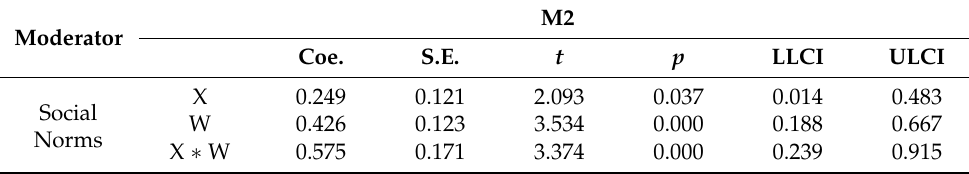
Table 3. The moderating role of social norms (2).